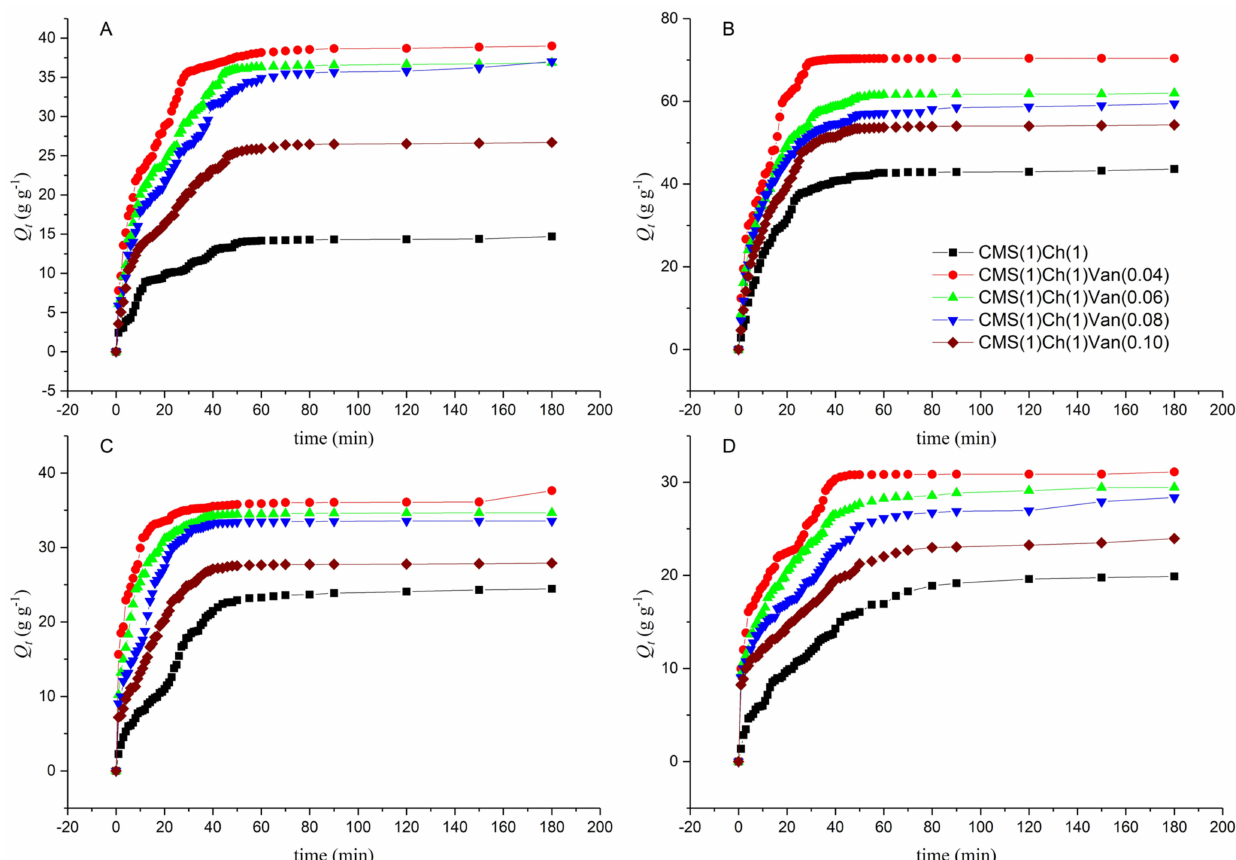
Figure 9. Swelling behavior of hydrogels in ( A ) 0.1% NaCl; ( B ) 0.3% NaCl; ( C ) 0.6% NaCl; ( D ) 0.9%